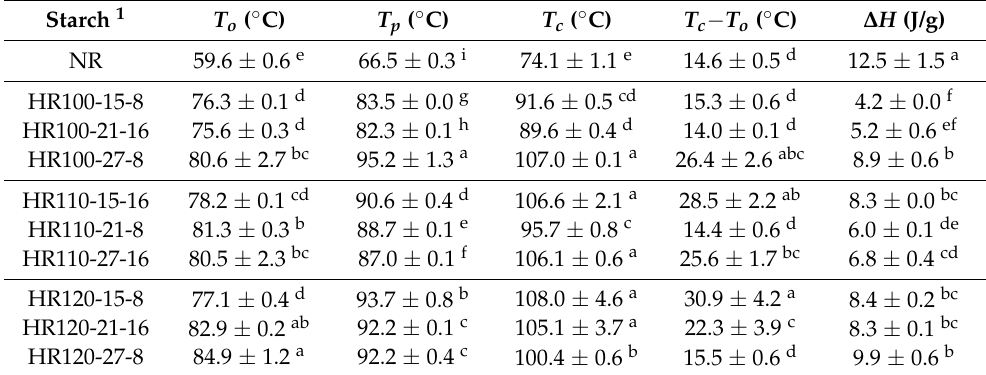
Table 2. Thermal properties of native and heat–moisture treated rice starches under different treat- ment